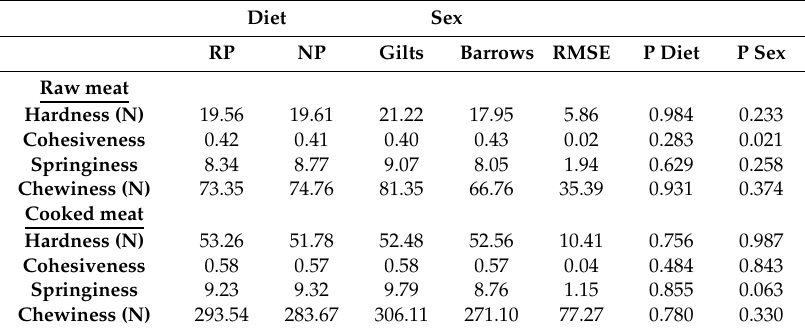
Table 5. Texture profile analysis (TPA) on raw and cooked loin.